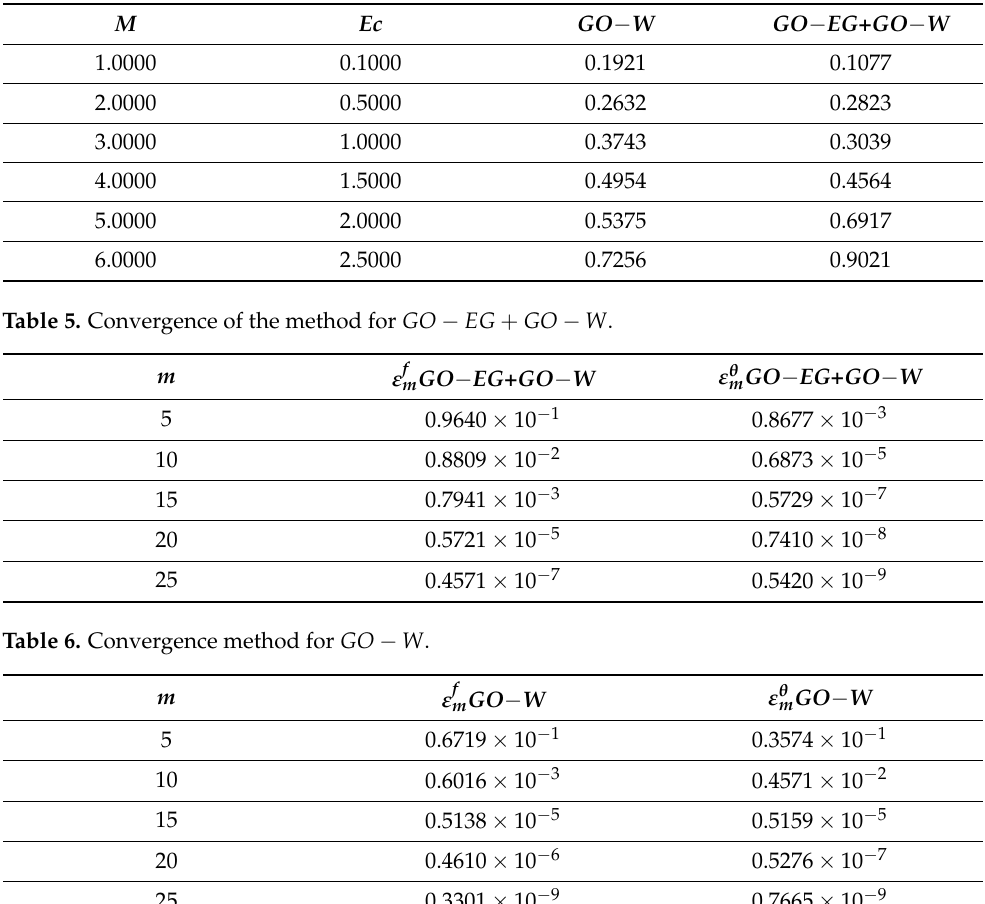
Table 4. Influence of the magnetic field parameter and Eckert number on Nusselt number.